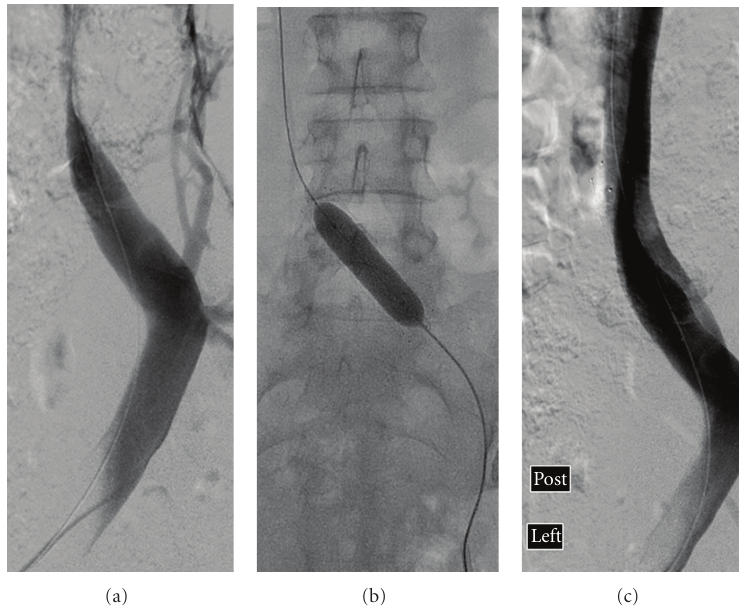
Figure 1: Venogram showing compression of the left common iliac vein (a), and inflation of balloon to expand stent in the left common iliac vein (b) with completion of the venogram after stent placement showing normal flow through left common iliac vein